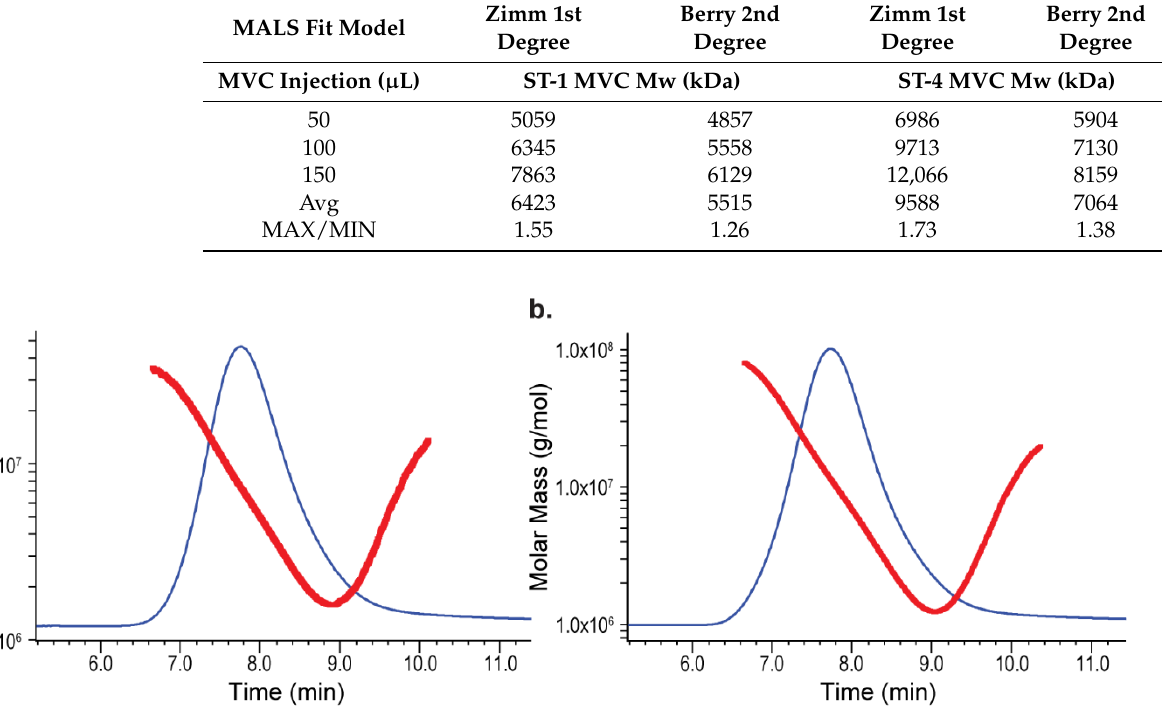
Figure 5. MVC Mw distribution on SEC-MALS: ( a ) ST-1 MVC; ( b ) ST-4 MVC. Each conjugate eluted out as a peak in blue trace. Conjugate molar mass distributions are shown as hook-shaped red lines. Table 3. MVC Mw comparison between Zimm and Berry fit models on